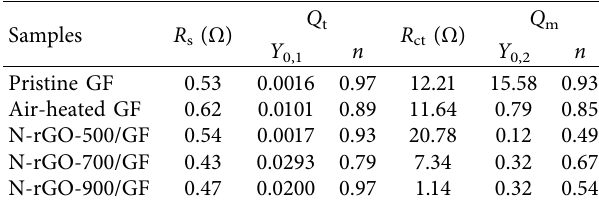
Table 5: The fitted values of electrochemical parameters.